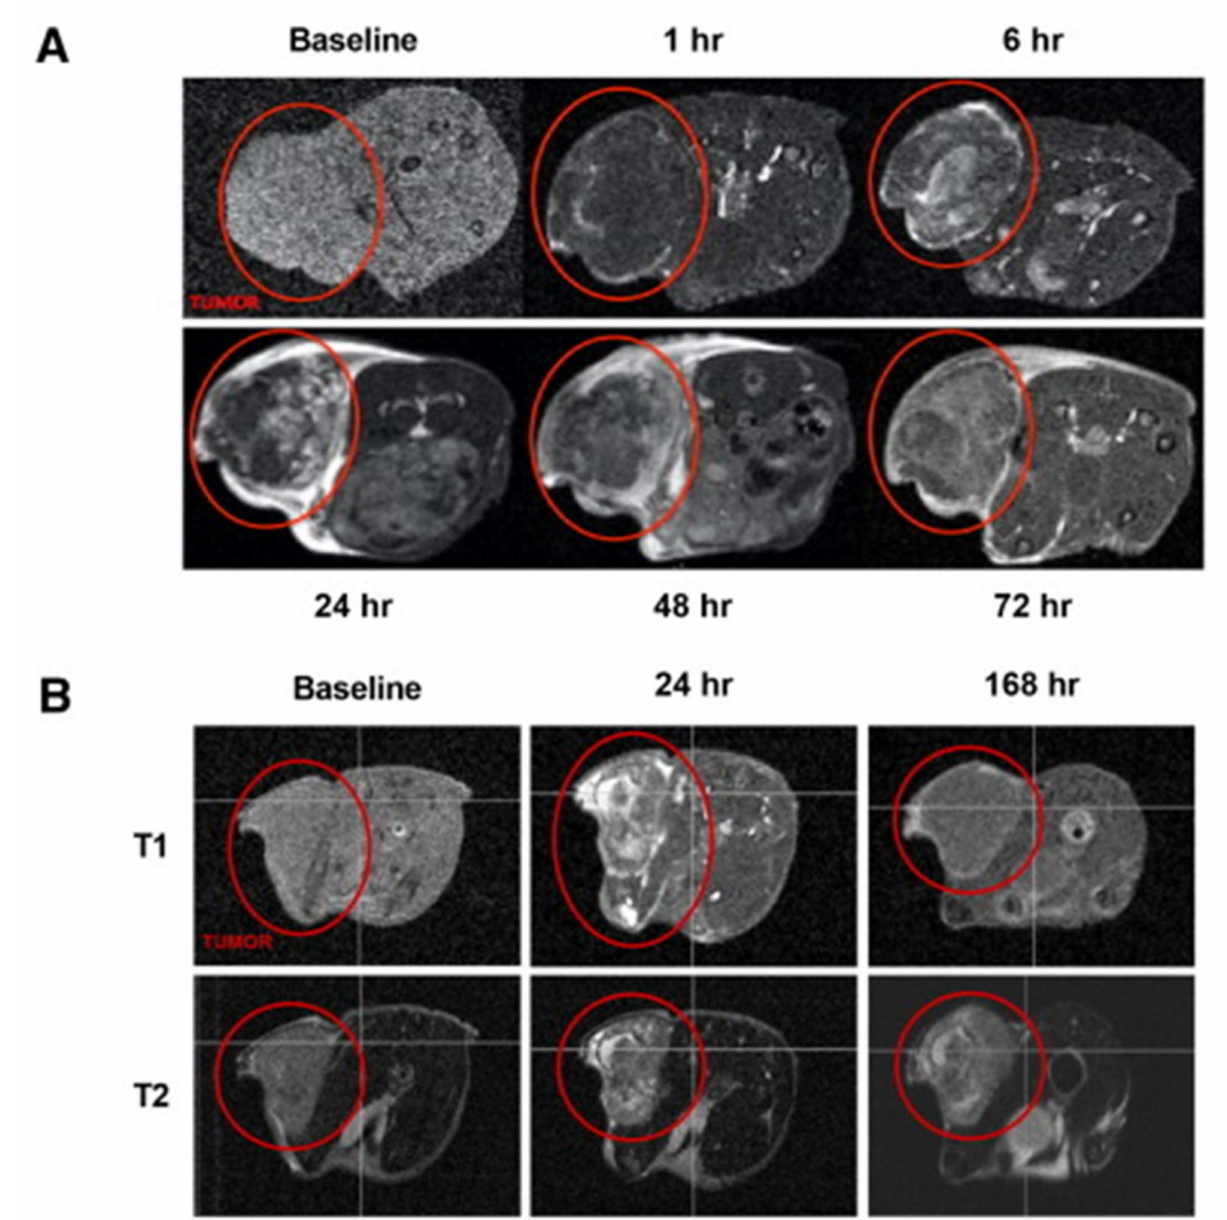
Figure 8. MRI imaging of iron-stabilized micelles in mouse ( A ) MRI of HCT16 mouse xenograft (1–72 h) and ( B ) (24–168 h). The red circles indicate tumors. Reprinted from [101], Copyright (2017) with permission from